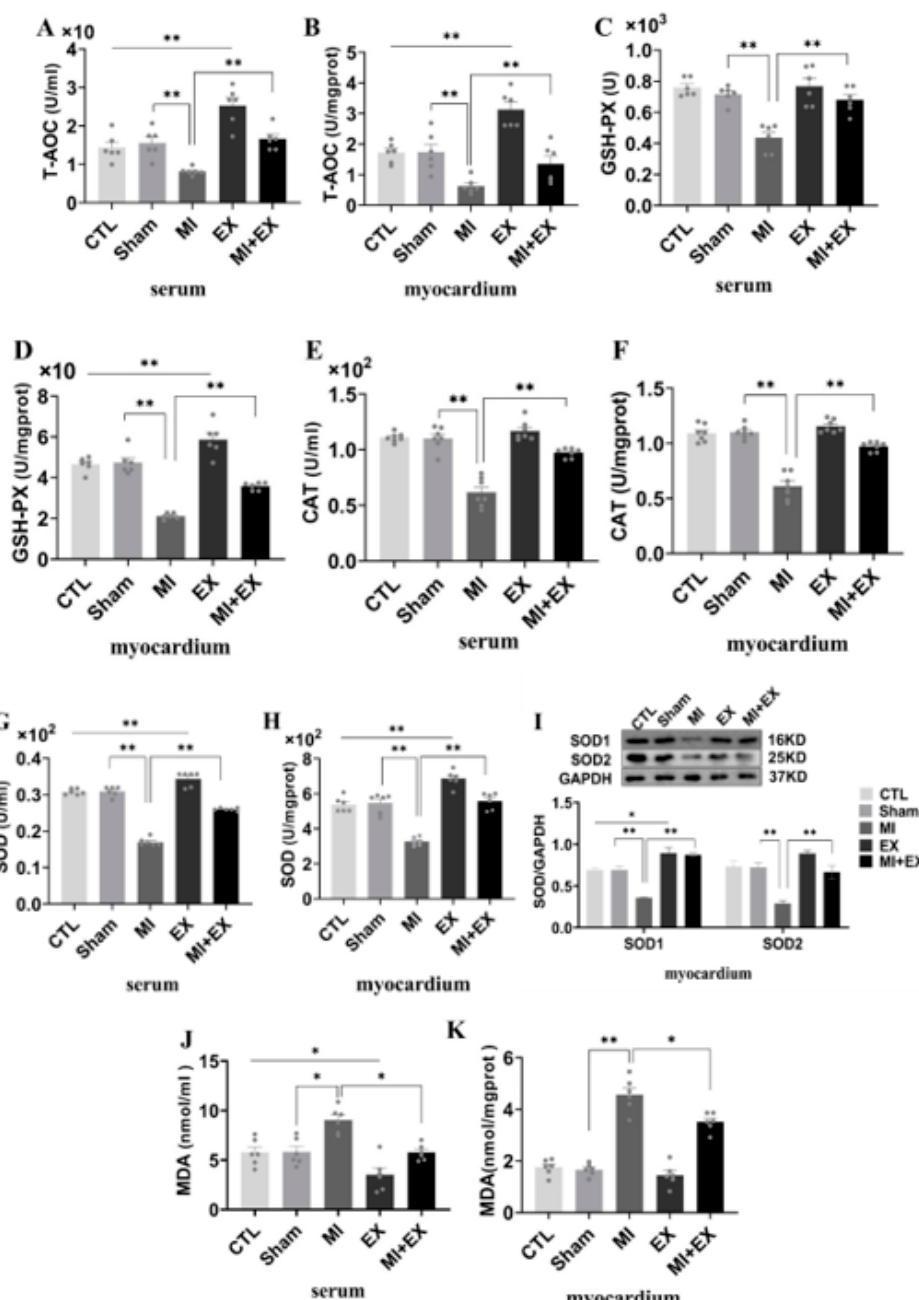
Figure 8. Effect of exercise and no exercise on myocardial oxidative stress following MI. ELISA of antioxidant levels. T-AOC ( A , B ), GSH-PX levels ( C , D ), CAT levels and SOD levels ( E – H ) in serum and tissue. ( I ) Representative blots of superoxide dismutase 1 and 2 (SOD1 and SOD2) and quantification of these data. ( J , K ) The level of MDA, an indicator of lipid peroxidation, was determined in rat serum and heart tissue samples with a TBARS kit. The values are presented as the mean ± SEM ( n = 3, 6, 7). CTL, normal control; MI, myocardial infarct; EX, CTL + exercise; MI + EX, MI + exercise. * p < 0.05, ** p < 0.01.